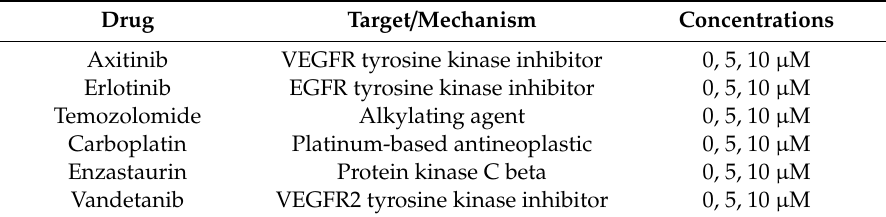
Table 2. Drugs used in screening of spheroids and